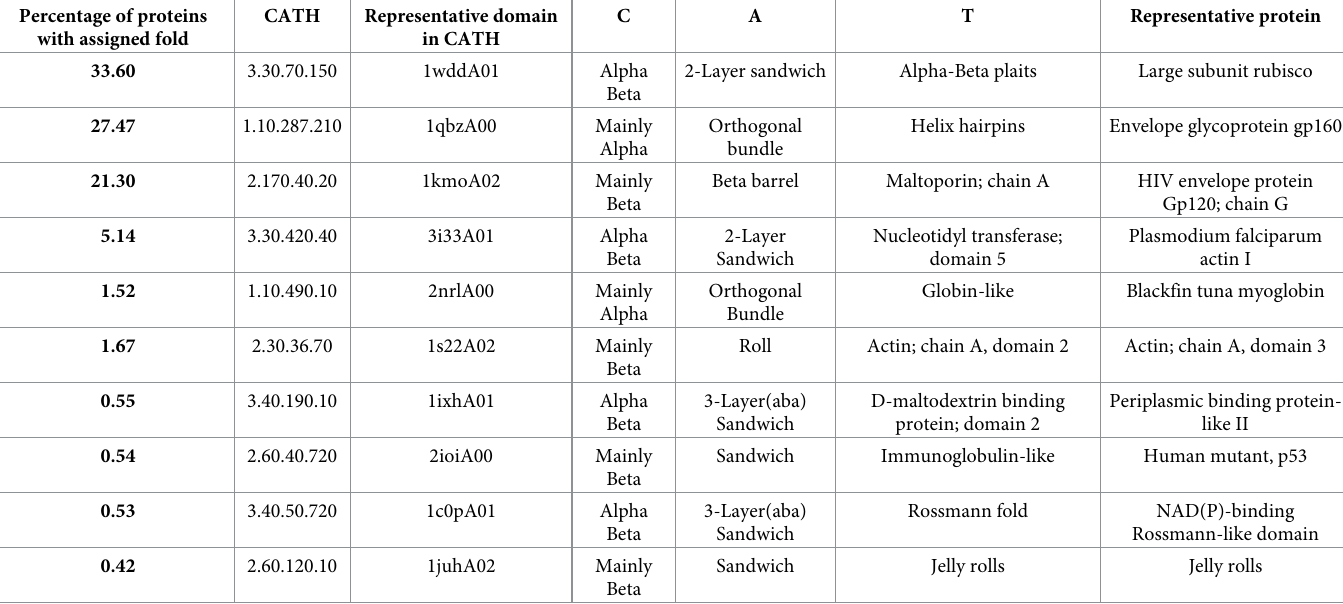
Table 1. Description of the top ten most abundant superfamilies found in the assignation of structure of the sequences with at least one peptide. Percentage of proteins with assigned